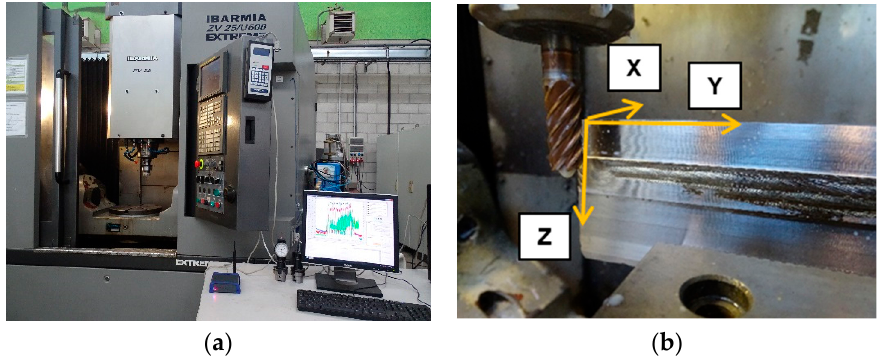
Figure 2. Machining experimental set-up: ( a ) machining equipment and ( b ) wall preparation. Materials 2020 , 13 , x FOR PEER REVIEW 4 of 16